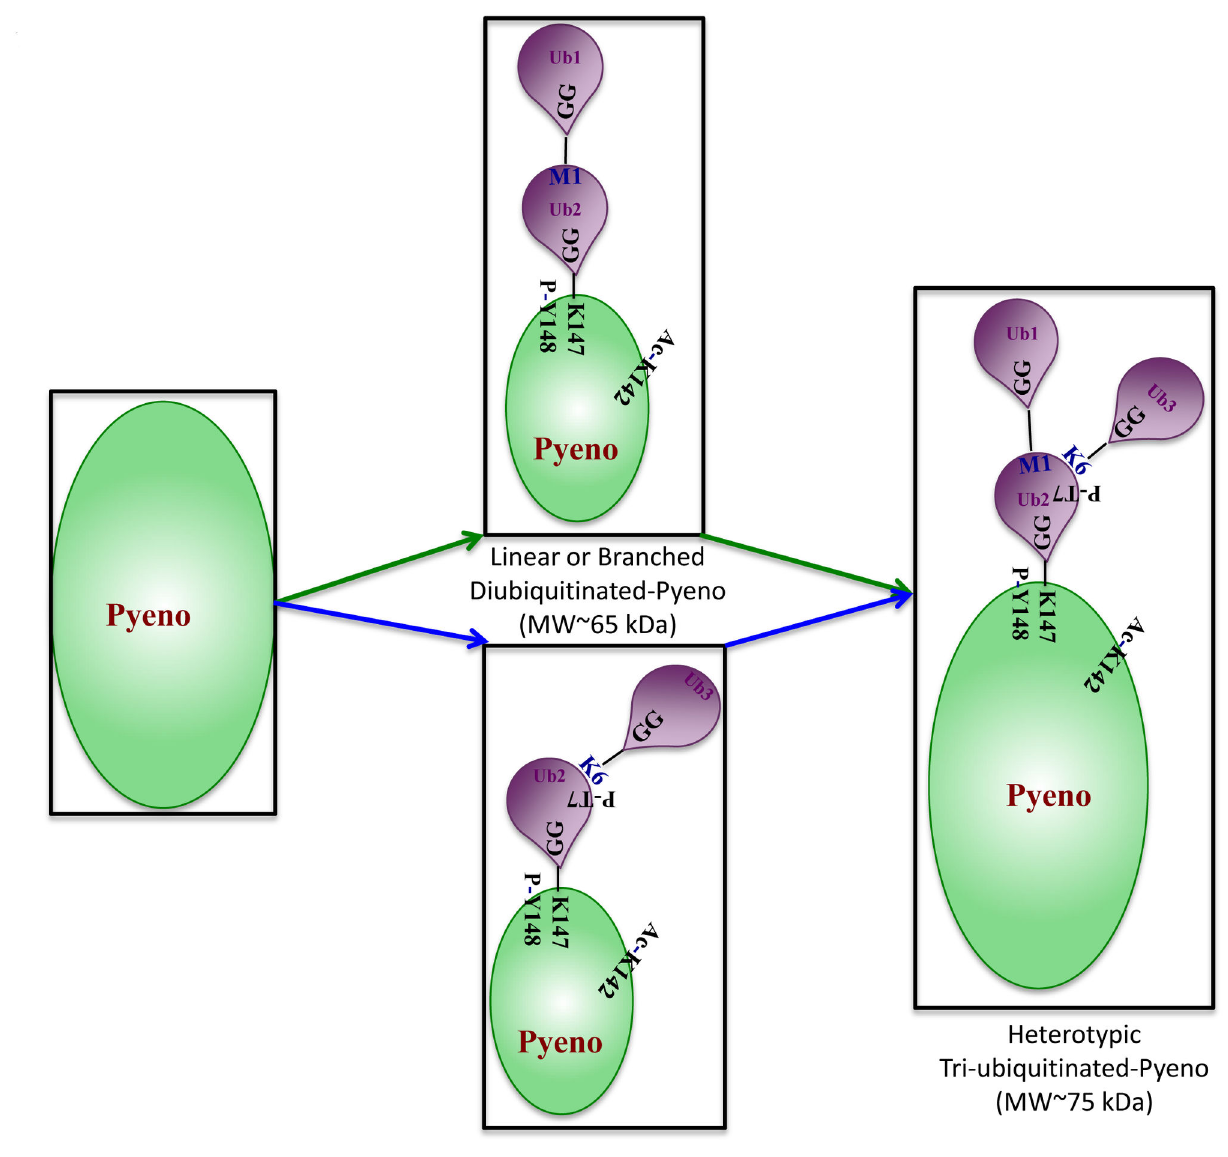
Figure 4. Schematic representation of post-translational modifications in Pyeno (determined in this study). It also shows two different intermediates with MW~65 kDa, that are possible on diubiquitination of Pyeno.